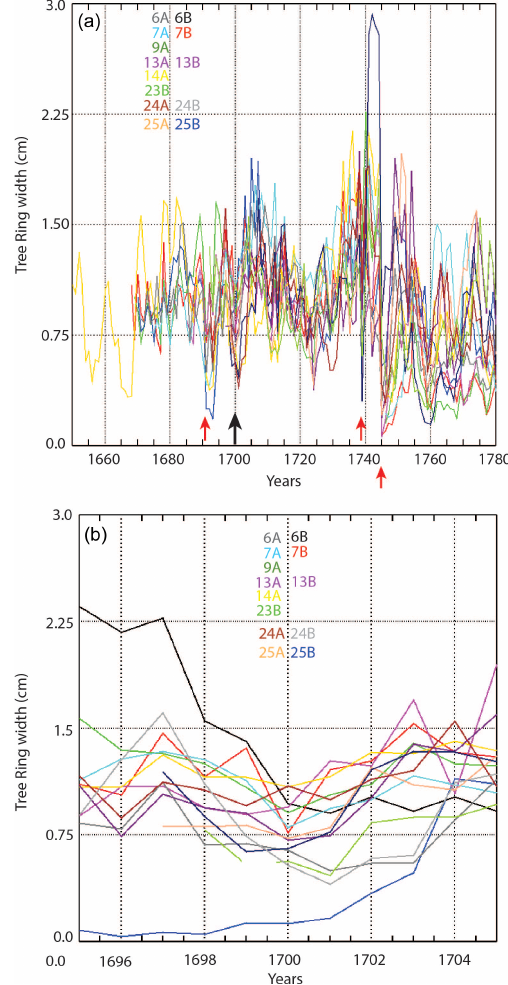
Figure 4. (a) Tree-ring growth records of old-growth Douglas-fir trees ( Pseudotsuga menziesii ) located in Mike Miller State Park, South Beach, Oregon (see Fig. 1). The vertical axis shows ring growth (in cm), and the time range covers several decades before and after 1700CE. The color of each growth record relates to alpha- numeric labels of individual trees shown in the legend, with the lo- cation of trees shown in Fig. 3b. The designation “A/B” represents two cores from the same tree. The black arrow marks the 1700CE date, and red arrows highlight the 1691, 1738, and 1745CE large growth reductions that may have been caused by significant clima- tological events. Panel (b) shows detailed growth record of trees in (a) 4 years before and after